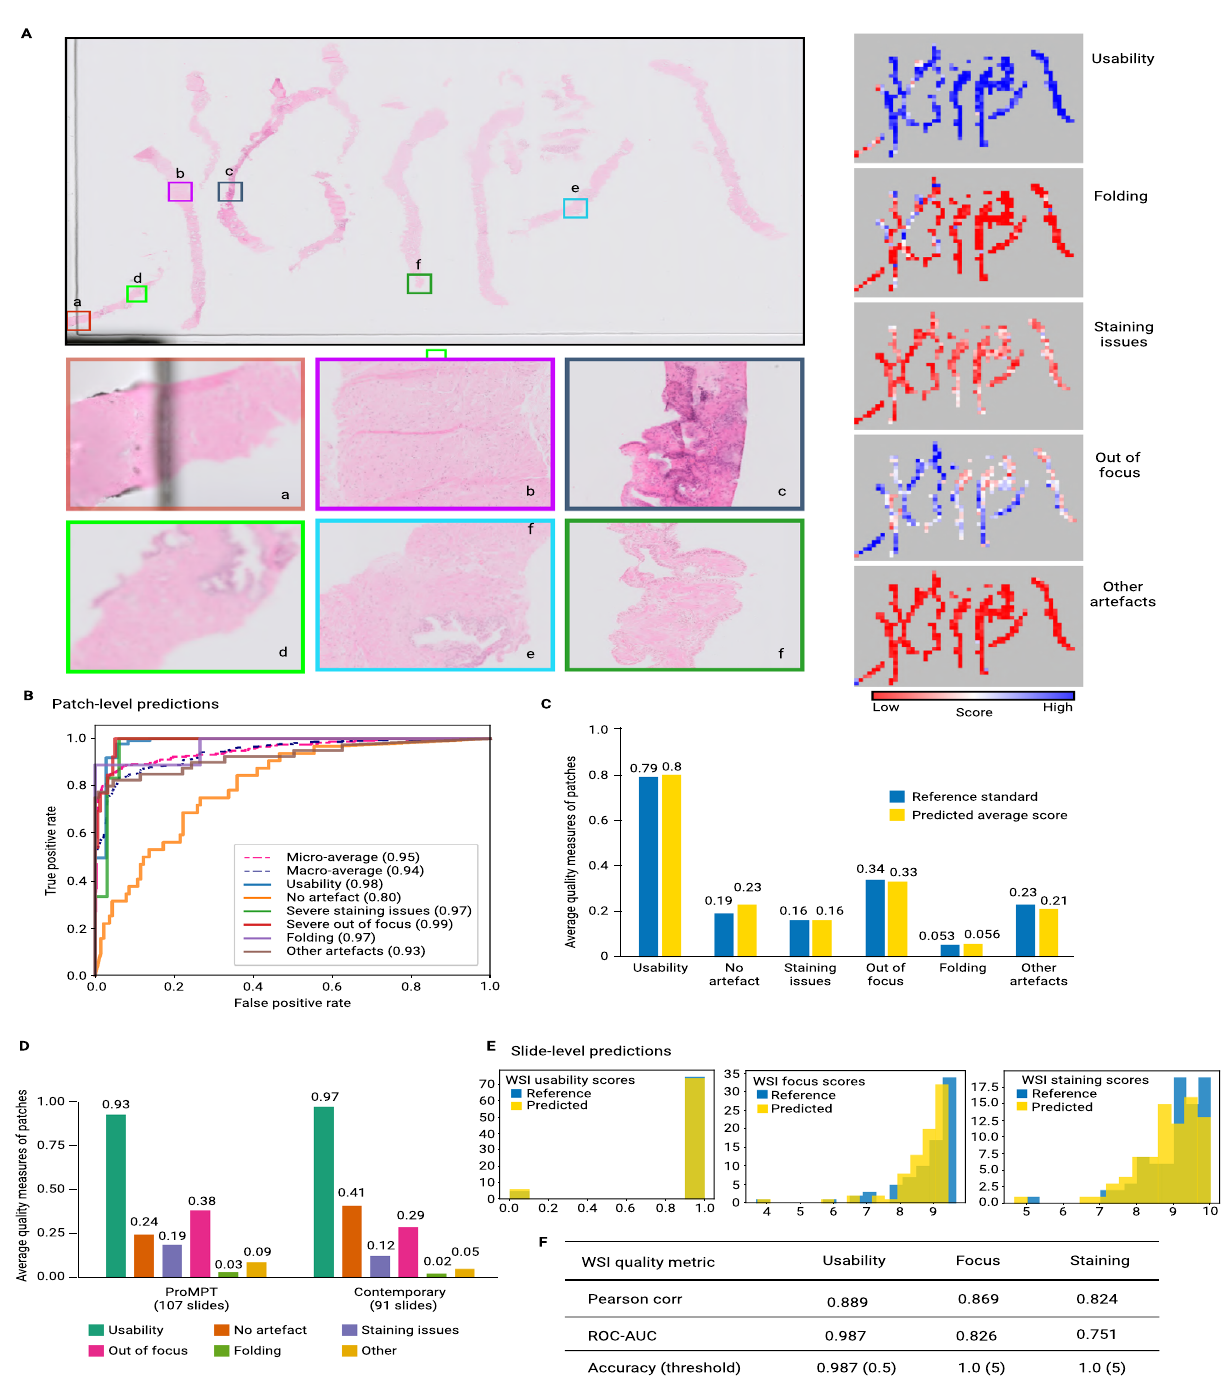
Figure 2. ( A ) H&E WSI (top left) and predicted quality overlays (heatmaps, right). The predicted usability overlay suggests that most image patches are usable. The individual artefact heatmaps indicate patches predicted to show the various artefacts, e.g., a = ‘other’ artefact, in this case coverslip edge and unusable, b & c = folded tissue (although the probability of b being usable is higher than c), d & e = severe focus issue predicted, affecting usability of d but without predicted impact on usability of e, f = slight H&E staining issue predicted (again with minimal impact on usability). Predictions like these could be used in an image analysis pipeline or be made available to a pathologist for regional investigation of artefacts. ( B , C ) Model performance for test dataset of image patches (combined ProMPT/contemporary): ( B ) ROC-AUC curves for each category of artefacts and overall usability, and ( C ) average predicted quality measures versus the reference standard as assessed by the pathologist. ( D ) Average predicted quality measures of all image patches in the ‘selected’ ProMPT slides (107 slides) and contemporary archive (91 slides). Such summarised patch-level QA of images provides general cohort-level quality metrics for computational pathology. ( E ) Distribution of ‘reference standard’ vs ‘predicted’ slide-level usability and quality scores for focus and H&E staining (0–10, low to high quality) for the test dataset of image slides (combined ProMPT/contemporary). ( F ) ROC-AUC and Pearson correlation coefficient of the slide-level predictions for usability and quality scores (0–10, low to high quality) and the reference standard values for the test dataset of image slides (combined ProMPT/